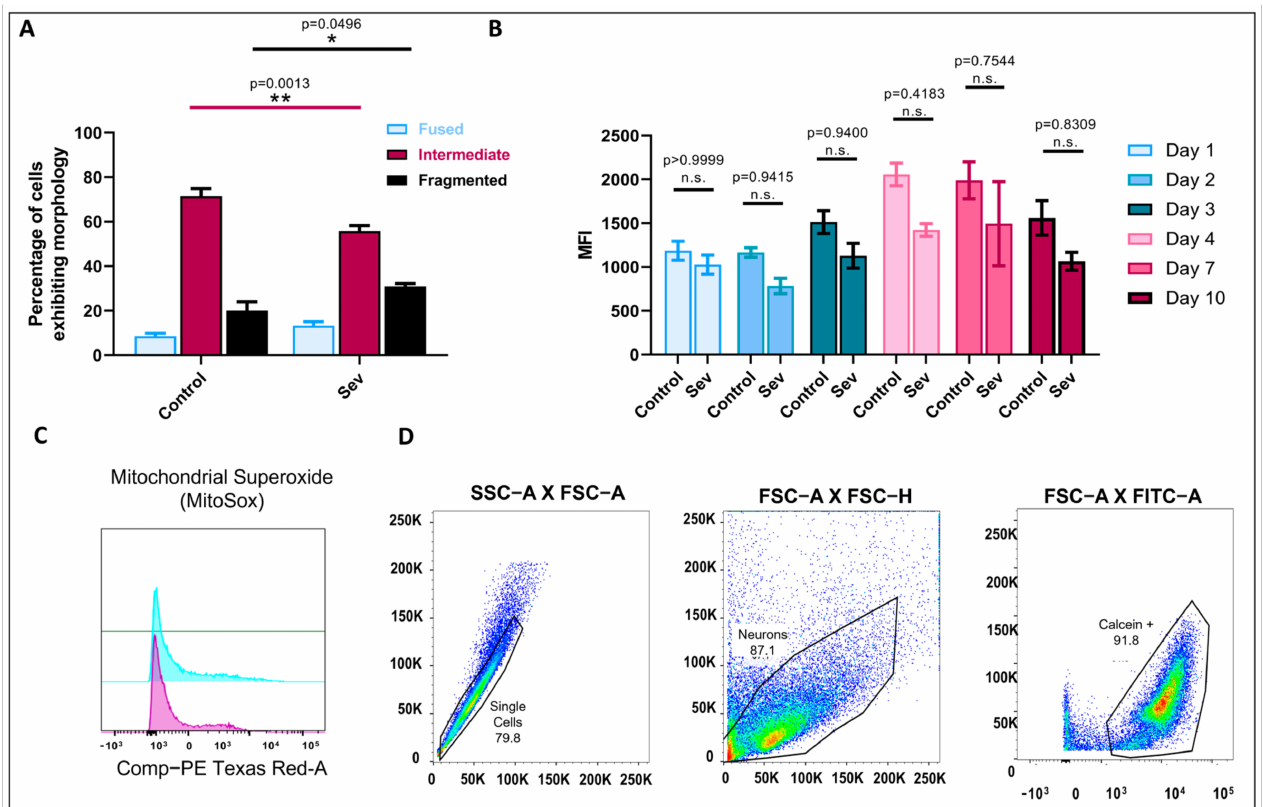
Figure 6. Sevoflurane exposure resulted in increased fragmented mitochondria. ( A ) Mitochondrial morphology quantification on day 4 post-anesthetic exposure comparing control versus sevoflurane- exposed cells. Bars indicate ± SEM, n = 8 dishes per condition, 15–20 images per plate. ( B ) Quantifi- cation of MFI of mitochondrial ROS production by control and sevoflurane-exposed cells on days 1, 2, 3, 4, 7, and 10. ( C ) Representative mean fluorescence intensity (MFI) of mitochondrial superoxide production by neurons exposed to sevoflurane compared to controls (untreated cells). ( D ) Gating strategy to select living neurons stained with Calcein AM. Bars are mean ± SEM ( A ) F (2,42) = 14.57, ** p = 0.0013 and * p = 0.496 using one-way ANOVA with Dunnett’s post hoc analysis for multiple comparisons in ( A ) and in ( B ) F (5,35) = 0.3706, p = 0.8653 by two-way ANOVA with Tukey’s post hoc analysis for multiple comparisons in ( D ). Cells extracted from n = 3–4 individual brains per